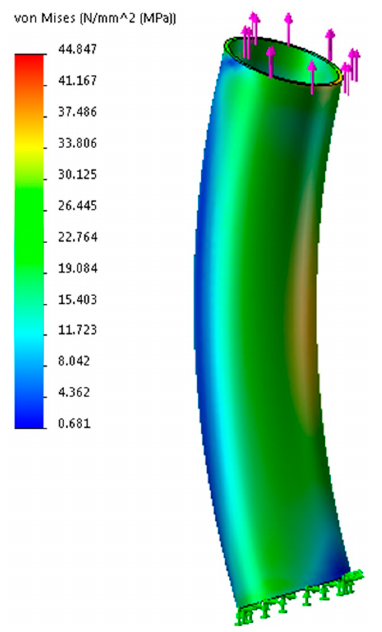
Figure 1. Tension simulation